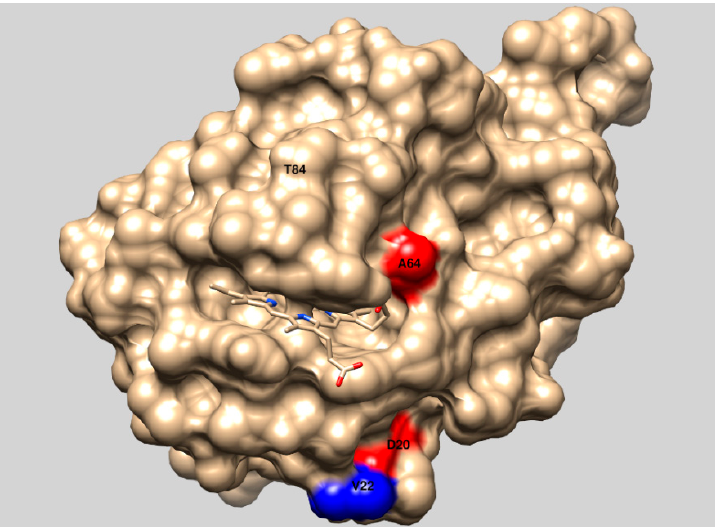
Figure 7. Presentation of the structure of the heme domain of CDH from P. chrysosporium (PDB accession code 1D7C) with labelled substitutions. The picture was made with UCSF Chimera 1.13.1. (University of California, San Francisco, CA, US).